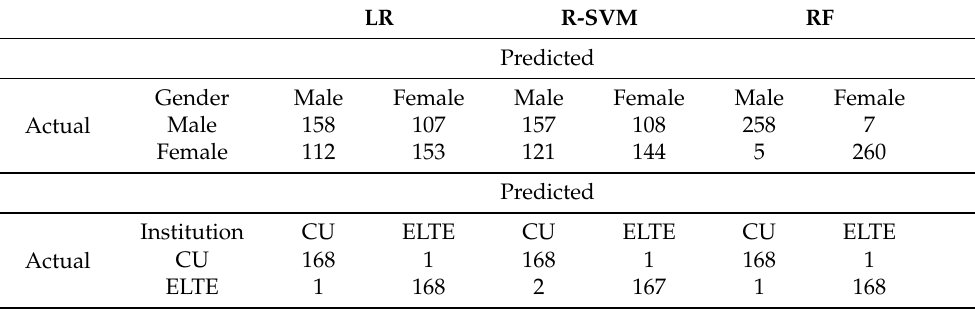
Table 5. Gender and Institution Identification Confusion